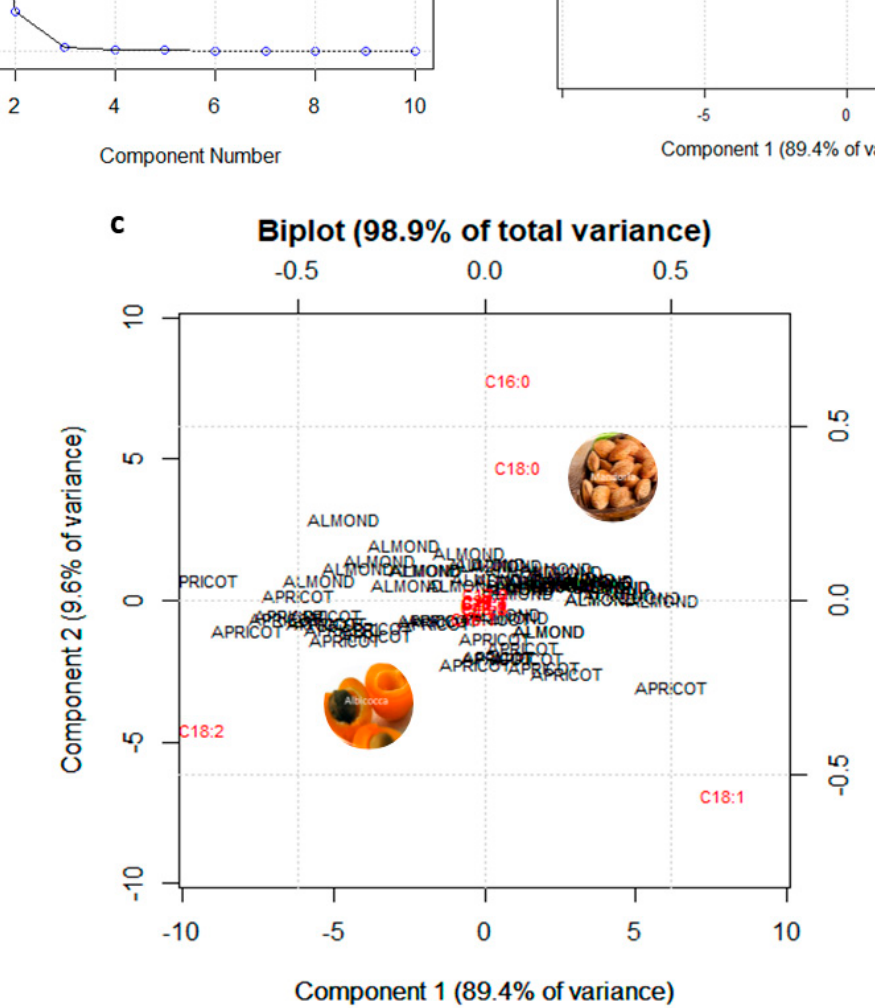
Figure 5. ( a ) Scree plot; ( b ) Score plot on PC–PC2; ( c ) Biplot (score and loading plot) on PC1–PC2.